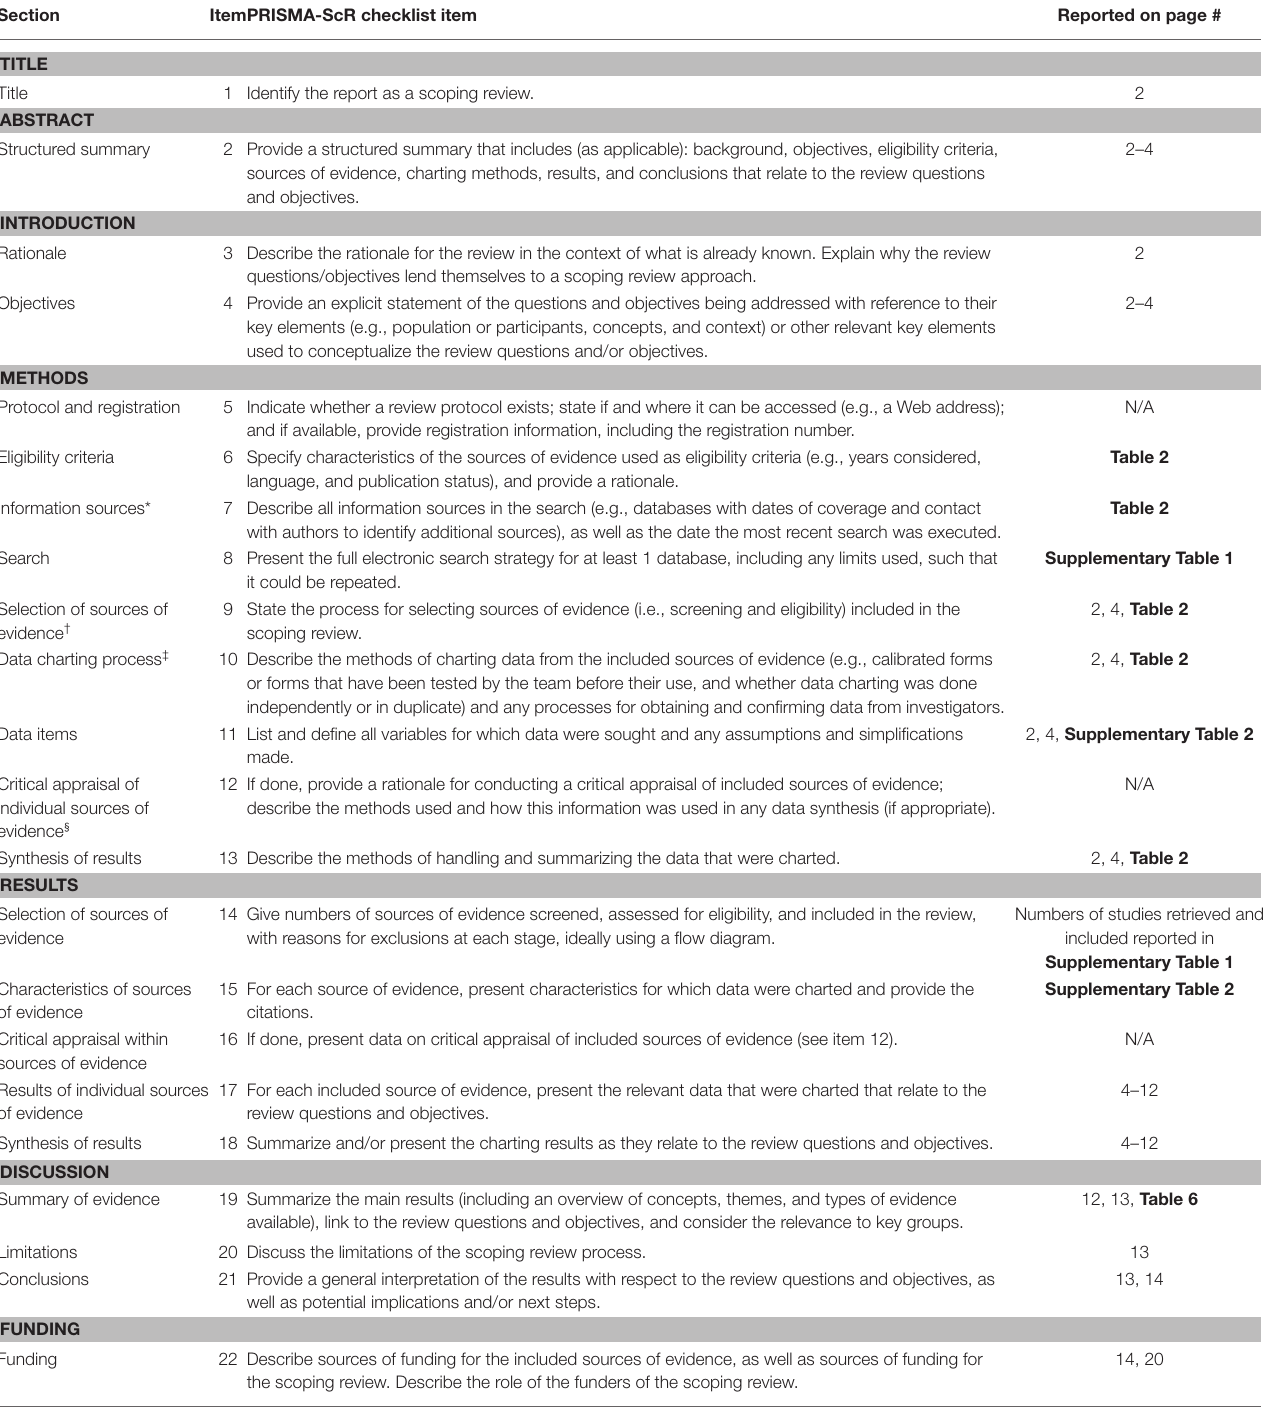
TABLE 1 | Preferred reporting items for systematic reviews and meta-analyses extension for scoping reviews (PRISMA-ScR) checklist (15).